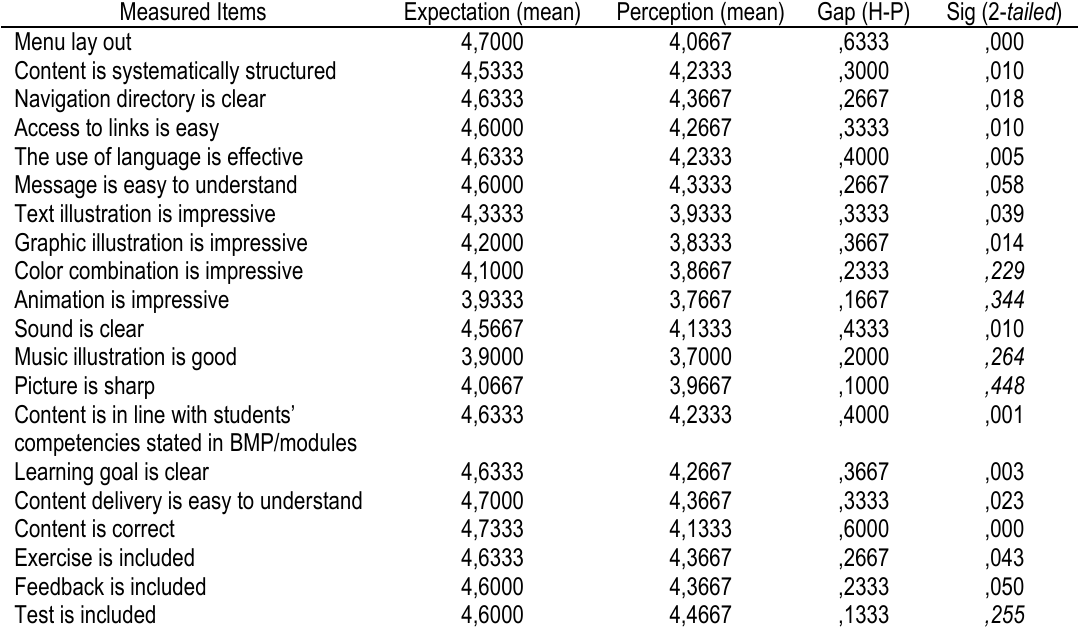
Table 1. Mean Differences between Students’ Expectation and Students’ Perception